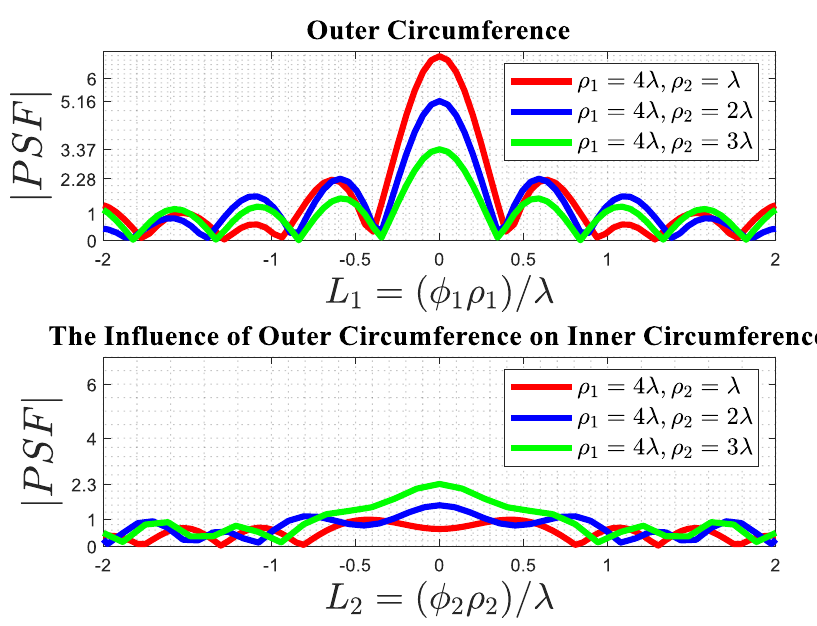
Figure 3. The Point Spread Function (PSF) of the outer circumference and its effectiveness on the inner one.